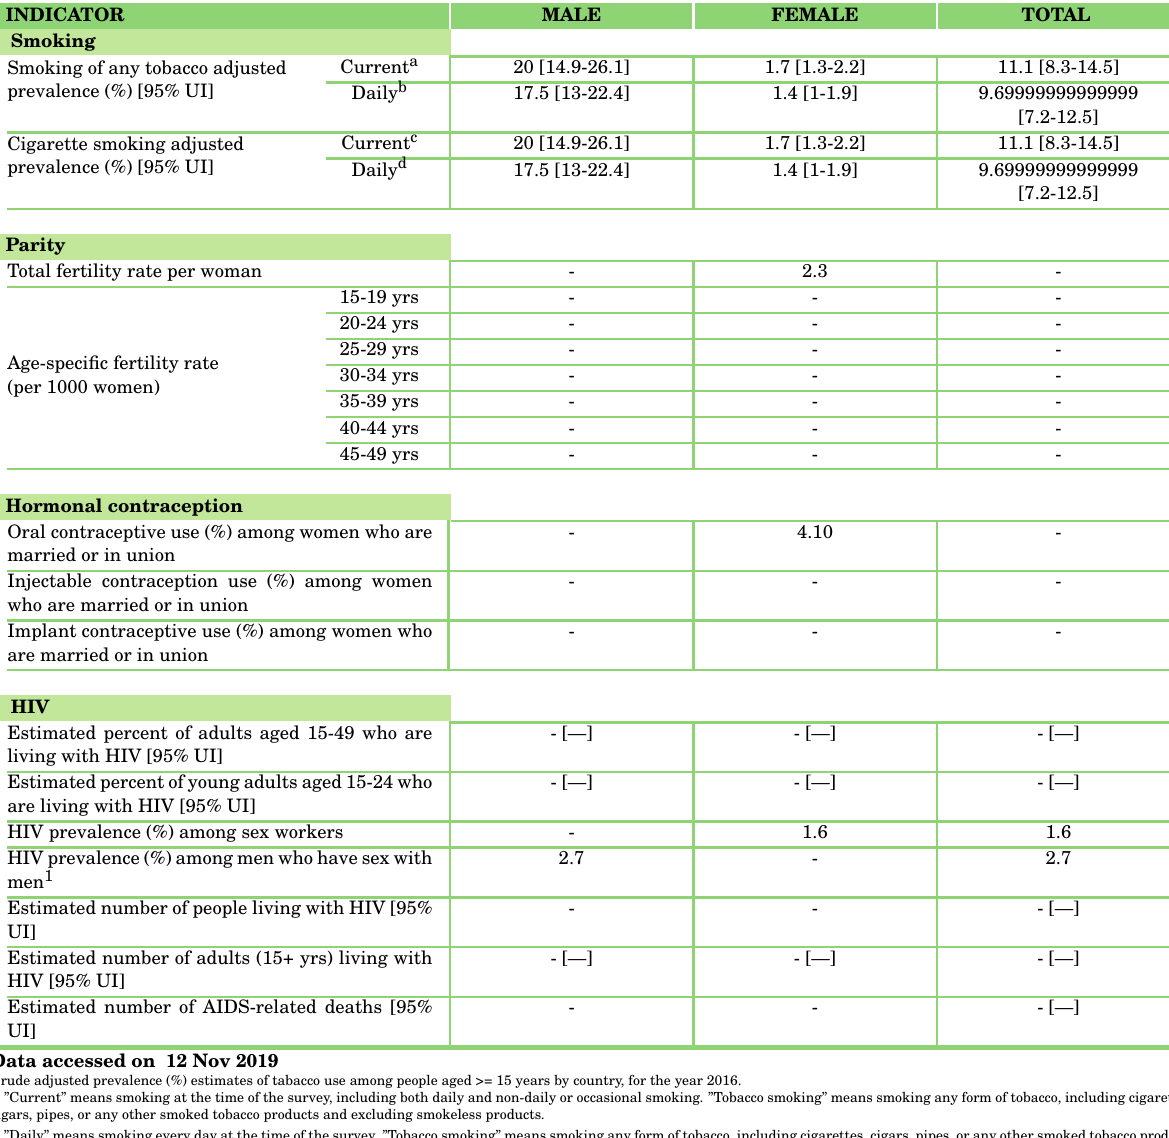
Table 39: Factors contributing to cervical carcinogenesis (cofactors) in